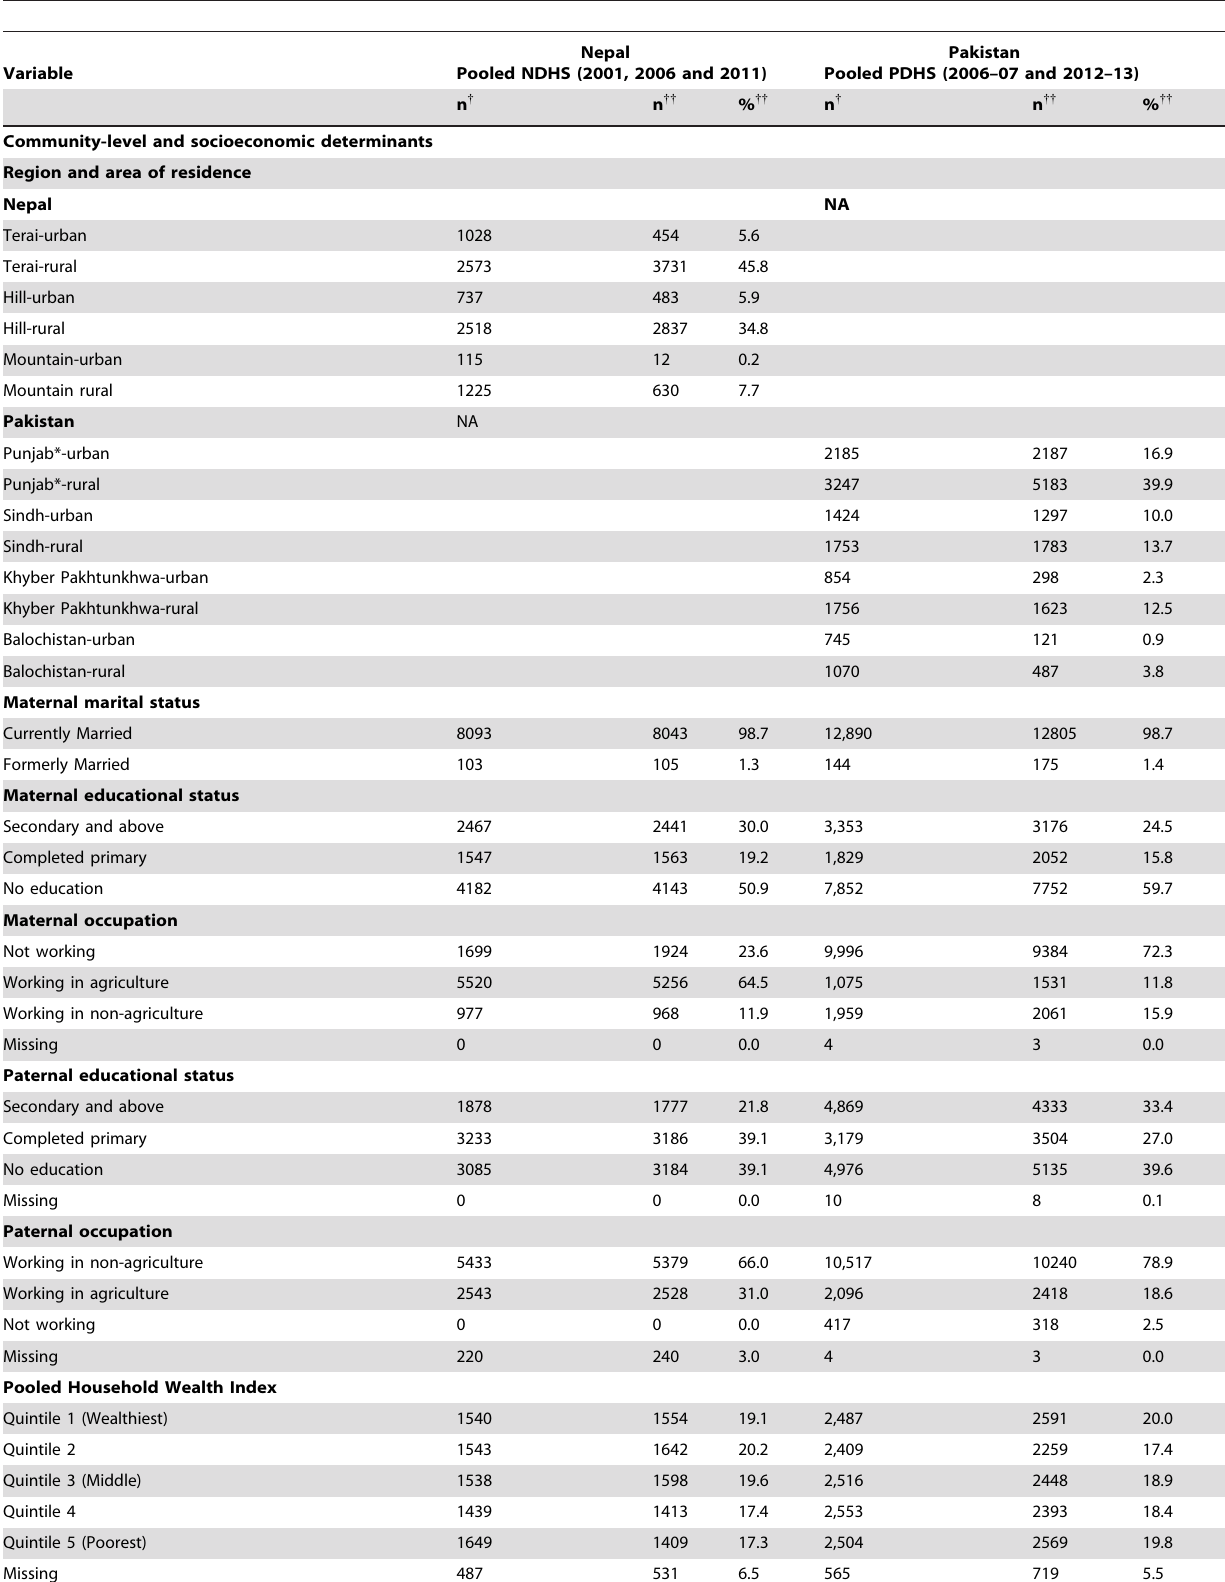
Table 1. Prevalence of community-level and socioeconomic status, maternal and newborn characteristics, and perinatal health care service determinants of singleton live-births within 5 years prior to interview in Nepal and Pakistan.